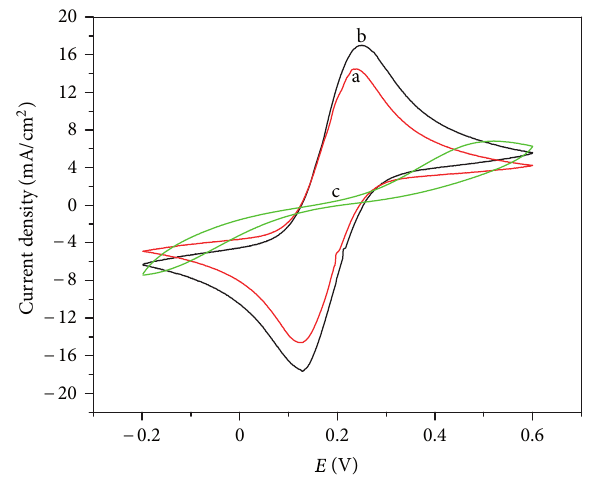
DTC/AuNPs in F 6: Cyclic voltammograms of (a) C 6 (red curve), (b) nanogold AuNPs electrode (black curve) and (c) bare Au electrode (green curve) in 5mM potassium ferrocyanide with 0.1M KCl as the supporting electrolyte at a potential scan rate of